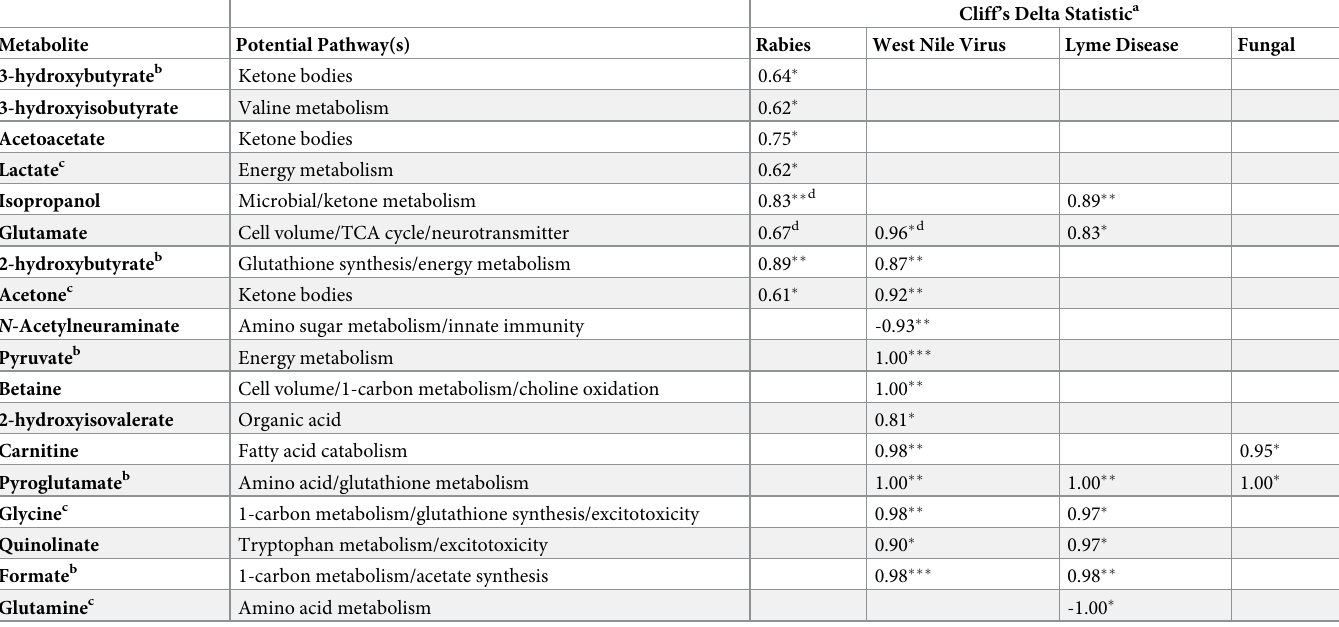
Table 4. Differences in cerebrospinal fluid metabolite concentrations compared to controls, by disease.